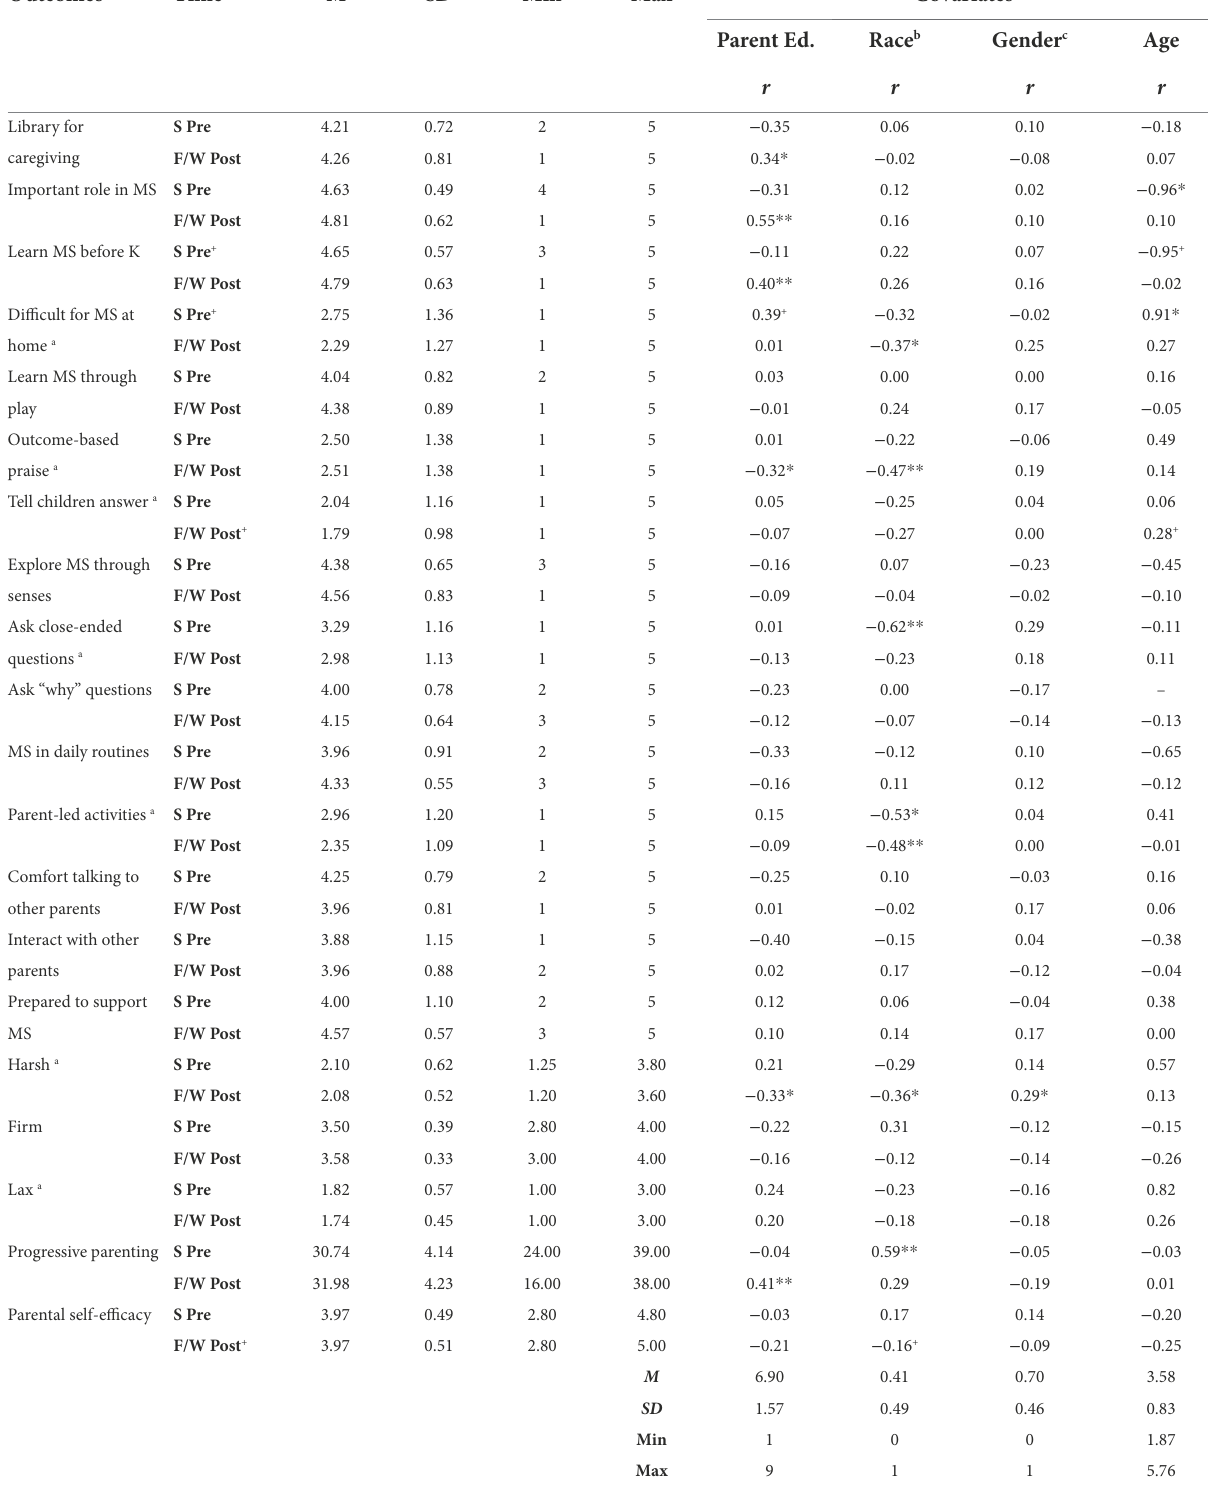
TABLE 3 Descriptive statistics and correlations for study variables (Spring pre-test n = 35, Fall/winter post-test n = 80). Outcomes Time M SD Min Max Covariates Parent Ed. Race b Gender c